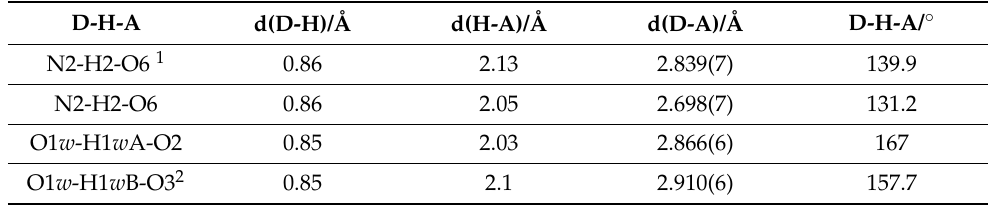
Table 2. Hydrogen Bonds for